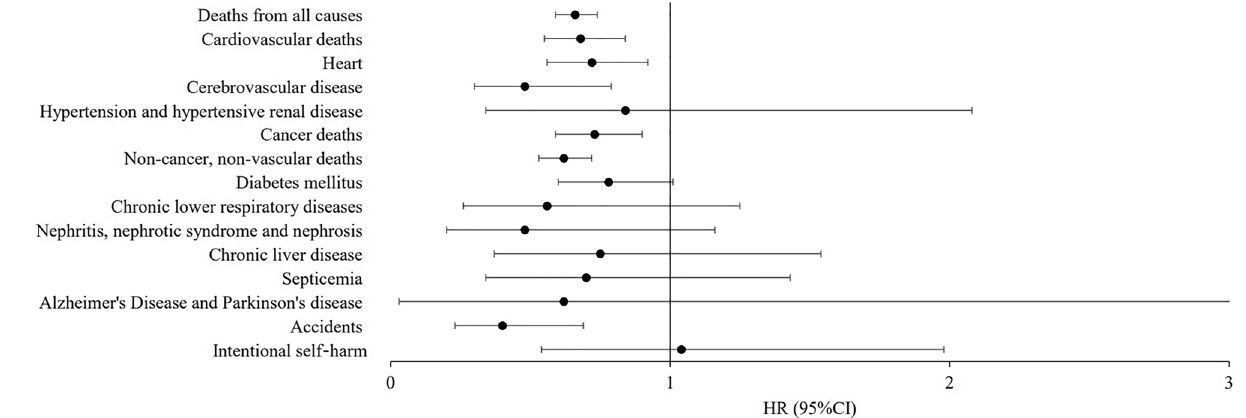
Figure 3. Death risks in type 2 diabetes mellitus patients prescribed SGLT2i versus DPP4i, according to specific causes of